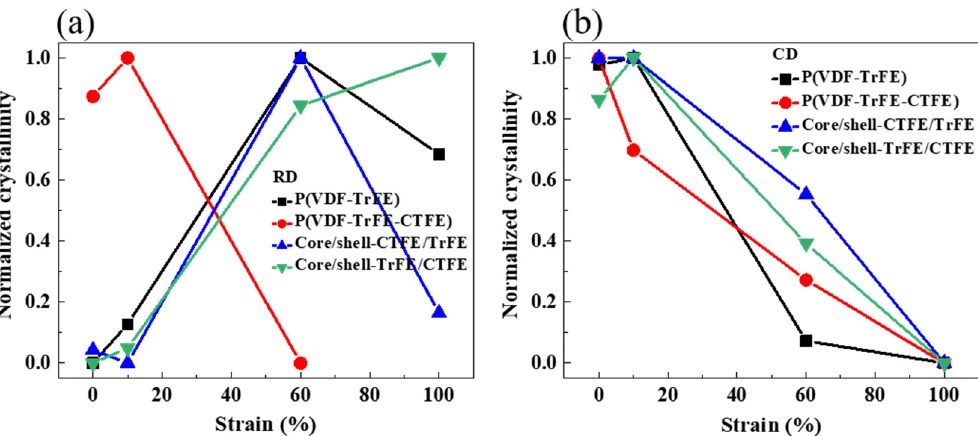
Figure 10. Strain dependence of the normalized crystallinity of the single and coaxial electrospun membranes in RD ( a ) and CD ( b ).